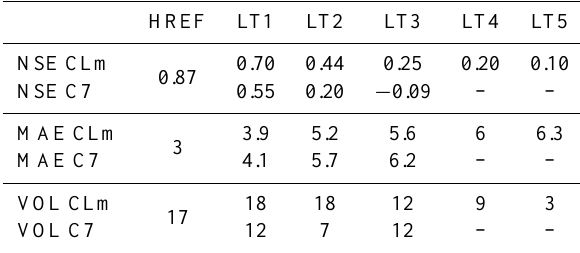
Table 3. Nash Sutcliffe efficiency NSE ( − ), mean absolute error MAE (m 3 s − 1 ) and volume error VOL (%) for the Sihl discharge in Zurich. The notation conventions are the same as in Table